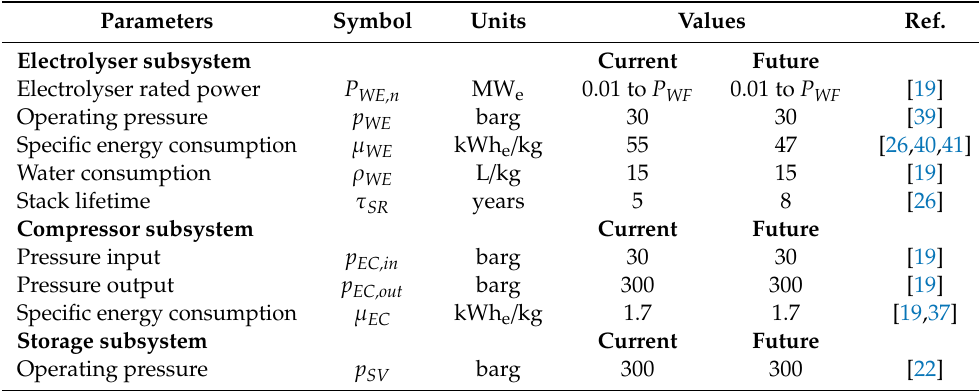
Table 2. Technical parameters in